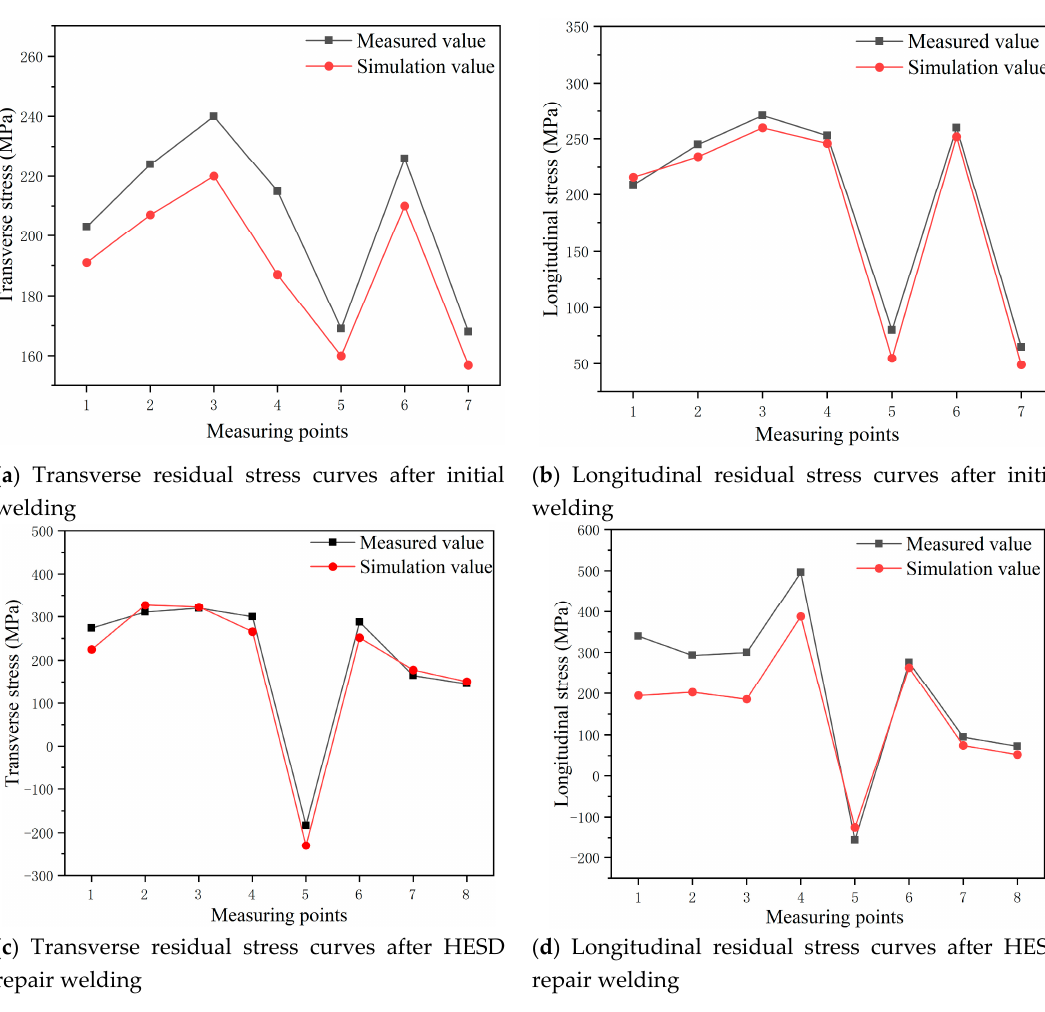
Figure 17. Comparison between the measured value and simulated value.